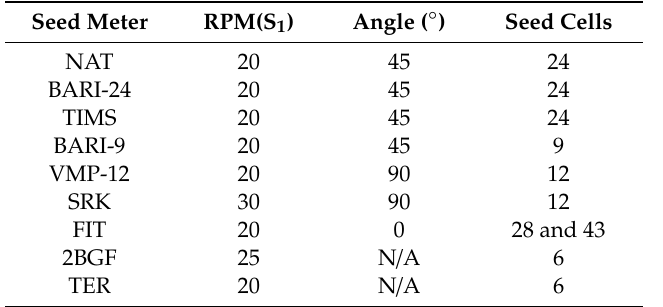
Table 1. Settings for base treatment (S 1 I 0 V 0 ) of e ffi ciency tests (S 1 as recommended seed plate revolutions per